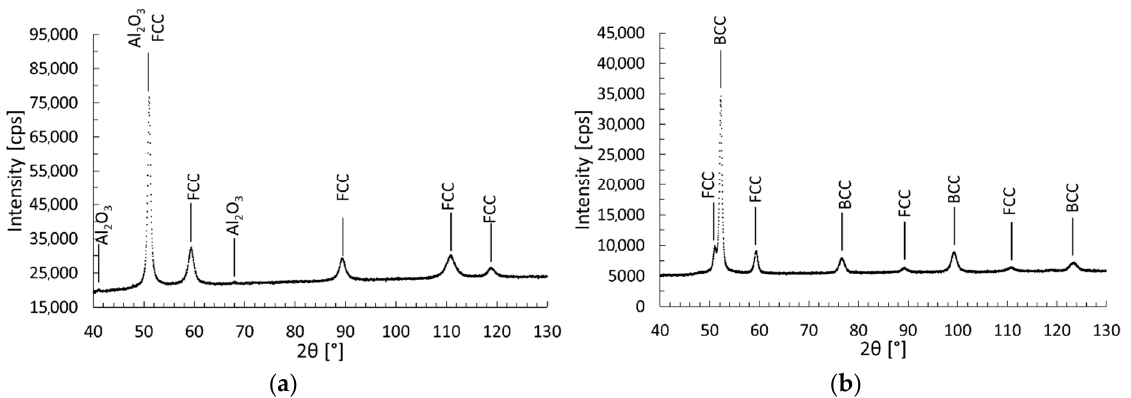
Figure 14. XRD of ( a ) Sample 3 (CL20ES) and ( b ) Sample 6 (CL50WS).